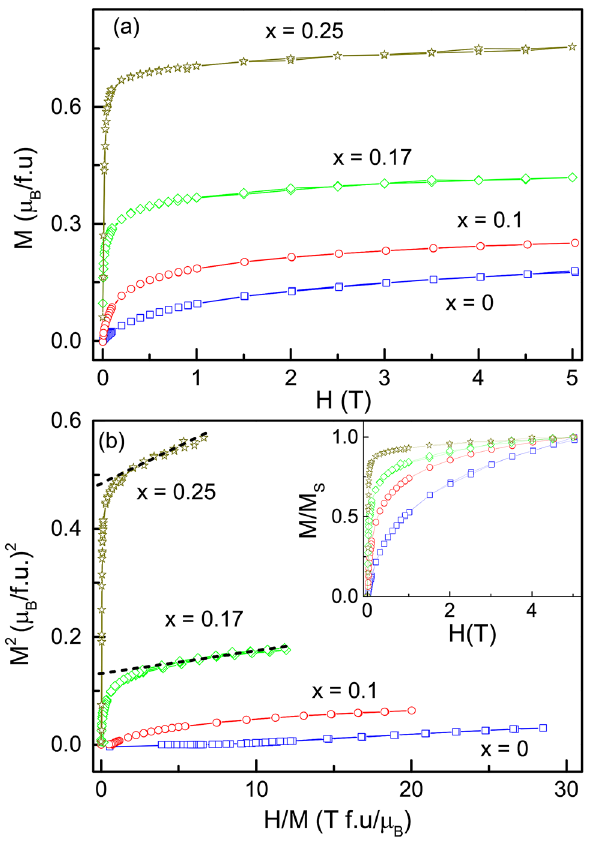
Cr Figure 3. ( a ) M(H) plots for Fe 2 Ti 1 x x Sn compositions measured at 5 K. ( b ) Arrot plot extracted for the − obtained M(H) curves. Inset presents the normalized M(H) plots indicating the ease of approaching saturation with the increase in Cr